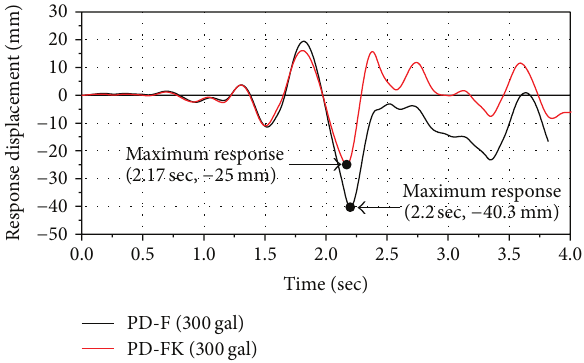
Figure 18: Comparisons between response displacement-time his- tory relationships of the PDF and PD-FK specimens during pseudo- dynamic tests for 300 gal.